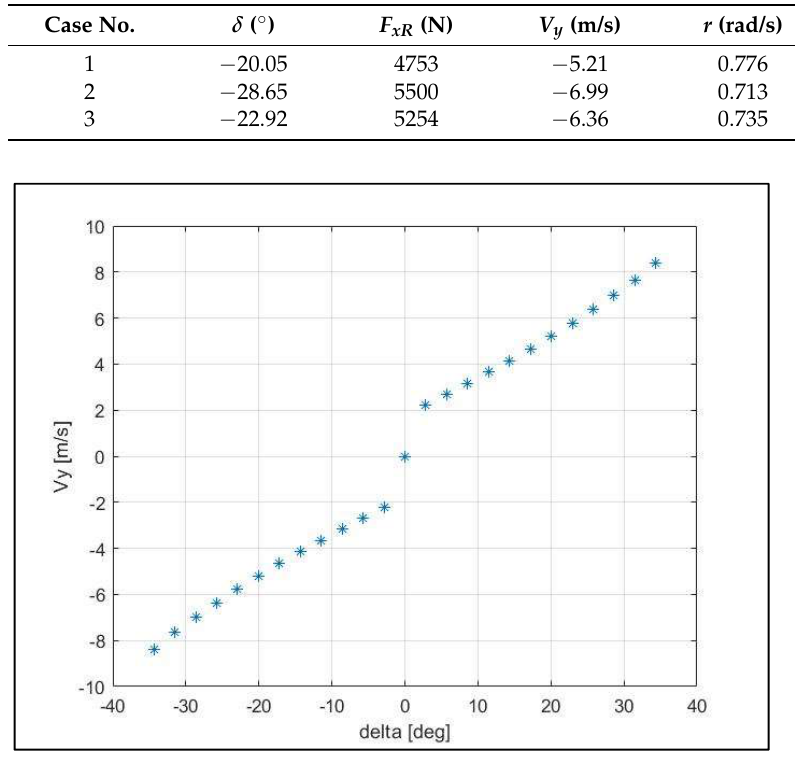
Figure 3. Equilibrium lateral speeds as a function of roadwheel angle.